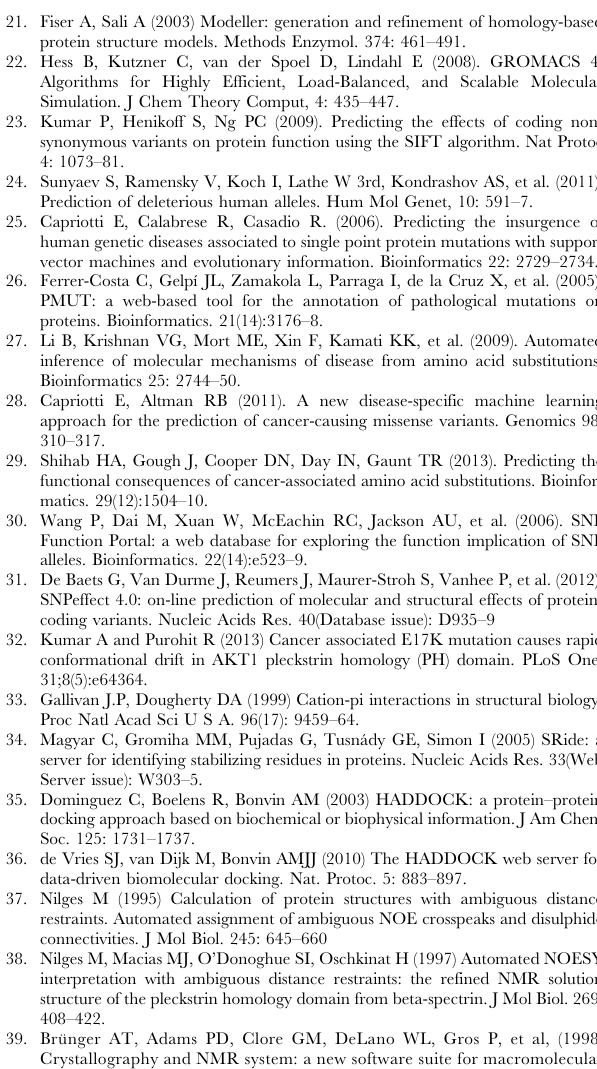
Table S1 Cancer-associated nsSNPs predicted using PhD-SNP, Pmut, MutPred, Dr Cancer and Fathmm server. g score, P score, molecular changes and prediction were obtained from MutPred server. SEQPROF results were obtained from Dr Cancer server. Allele highlighted in bold has been predicted to show Cancer- associated